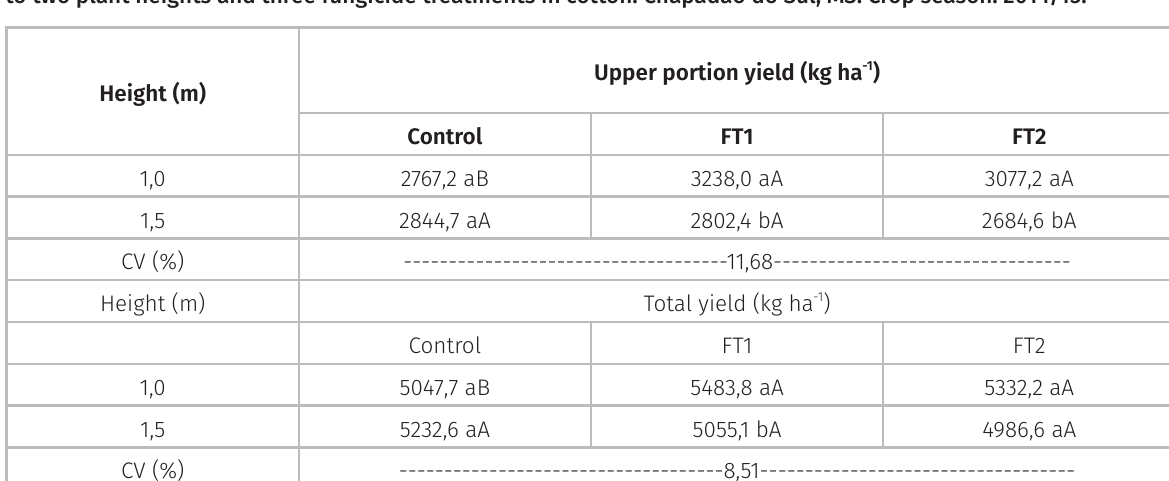
Table V. Cotton seed yield (kg ha -1 ) in the upper portion of the plant and in the whole plant (total yield), submitted to two plant heights and three fungicide treatments in cotton. Chapadão do Sul, MS. Crop season: 2014/15.